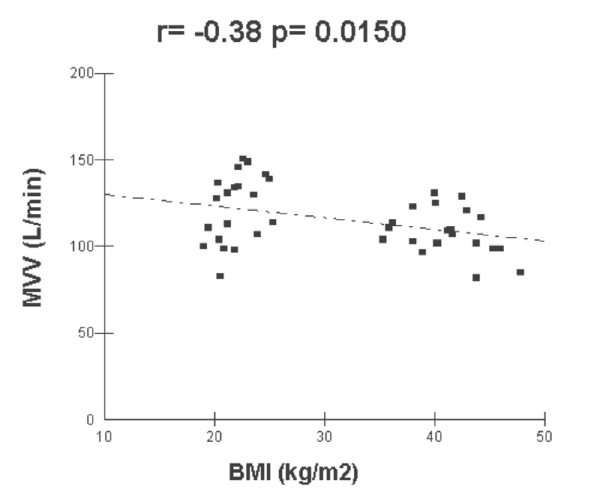
Figure 3 - Correlation between the body mass index (BMI) and the maximum voluntary ventilation